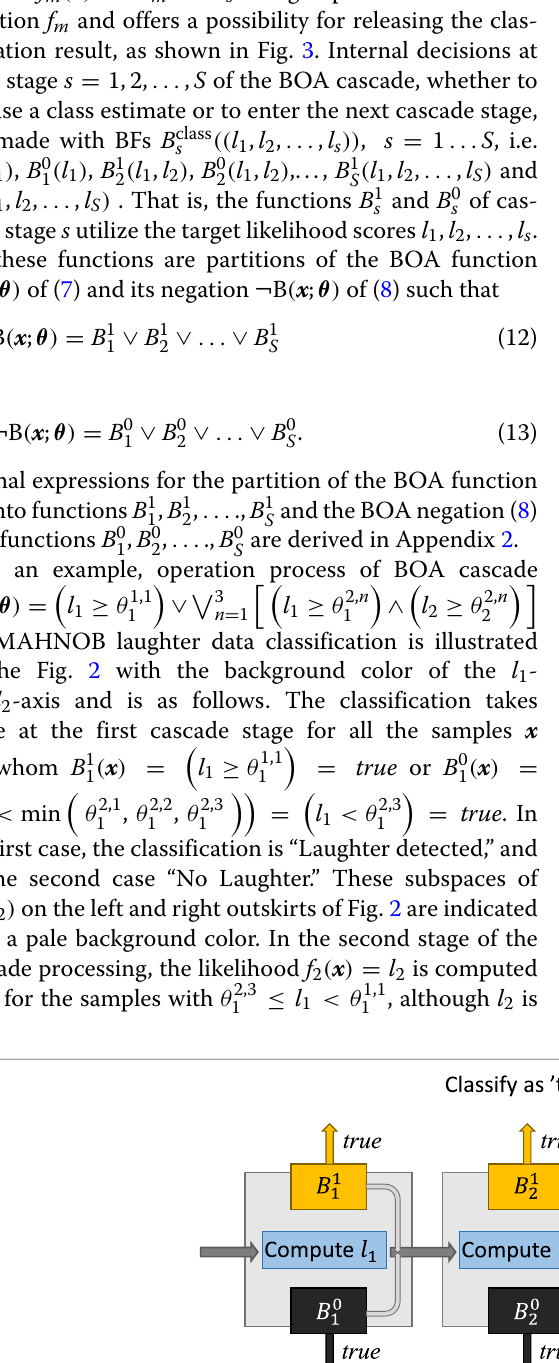
are partitions of BOA S